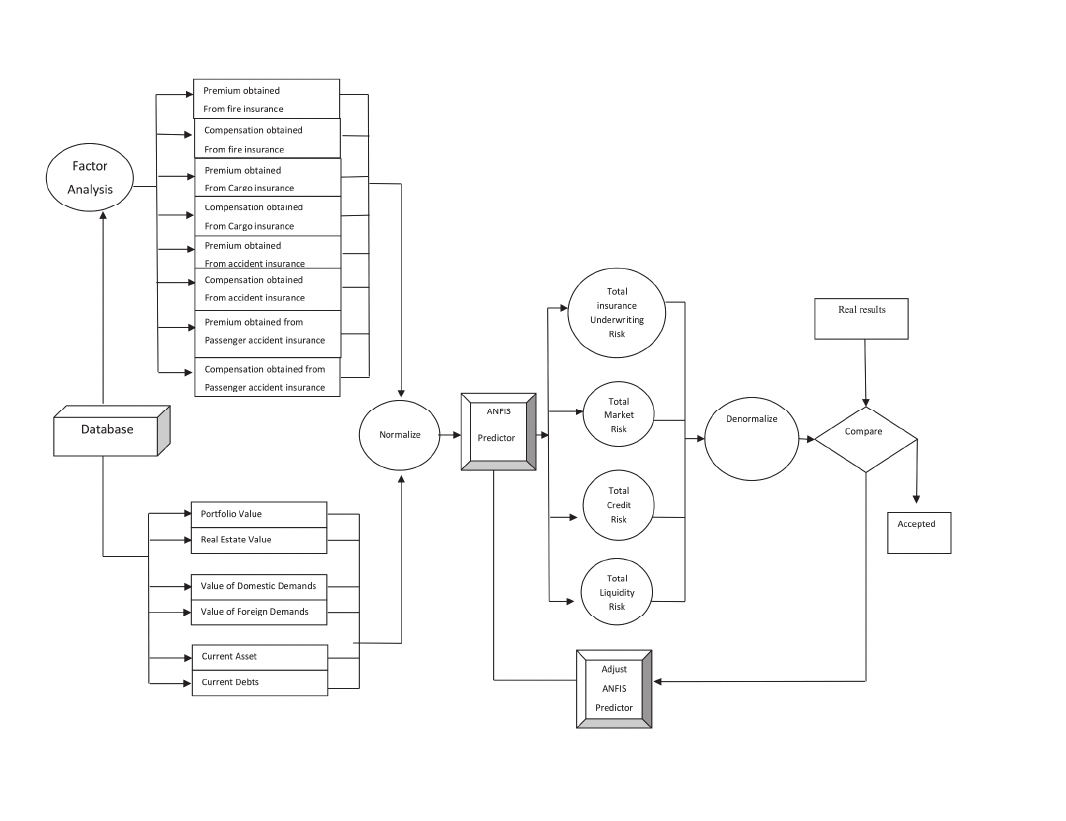
Fig. 1. Research Conceptual